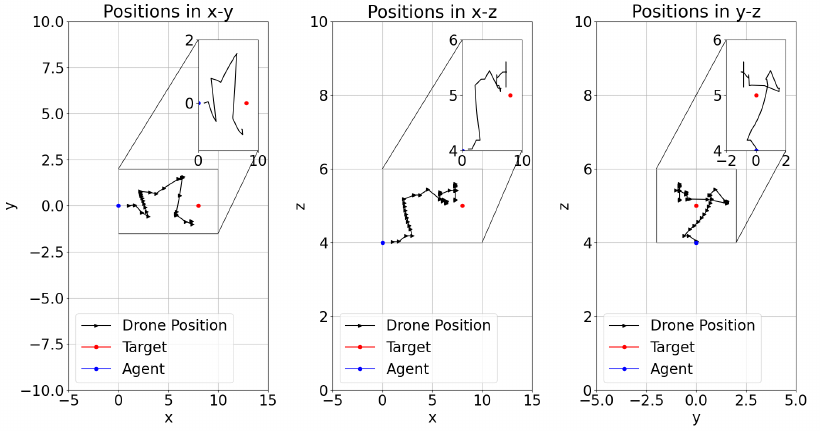
Figure 15. Model-1 Training Episode 2285 Drone Position.